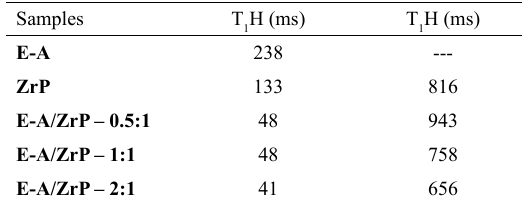
Figure 5. Domain curves of the ZrP and modified phosphates. Table 4. T1H of the ZrP and modified